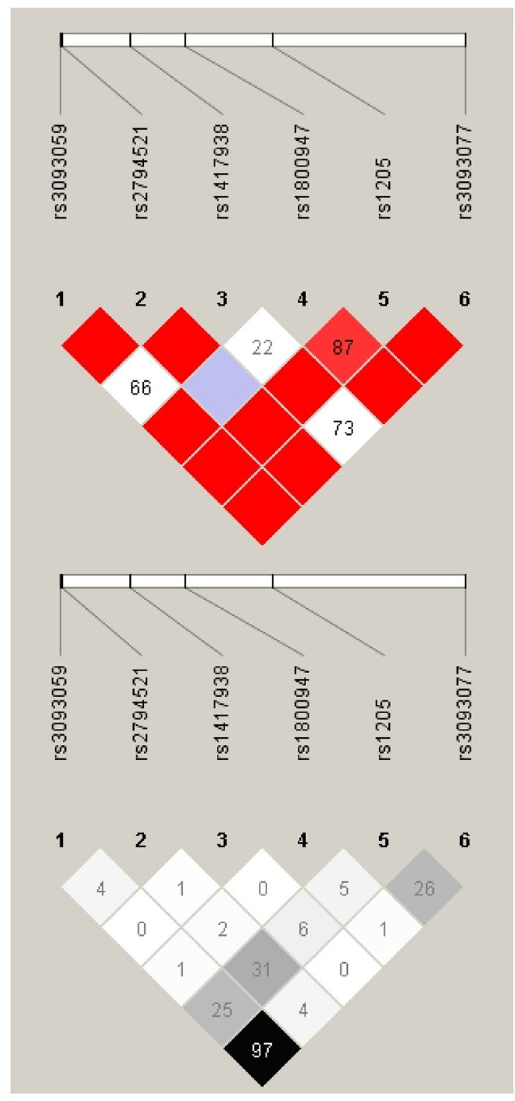
Figure 1. Linkage disequilibrium (LD) structure of the CRP tag-SNPs genotyped in the sample of SAPPHIRe study. The LD structure was analyzed using the Haploview (v. 4.2) program. The upper diagram presents the pair-wise LD levels measured by Lewontin’s |D’|, while the lower diagram presents the pair-wise LD levels measured by r 2